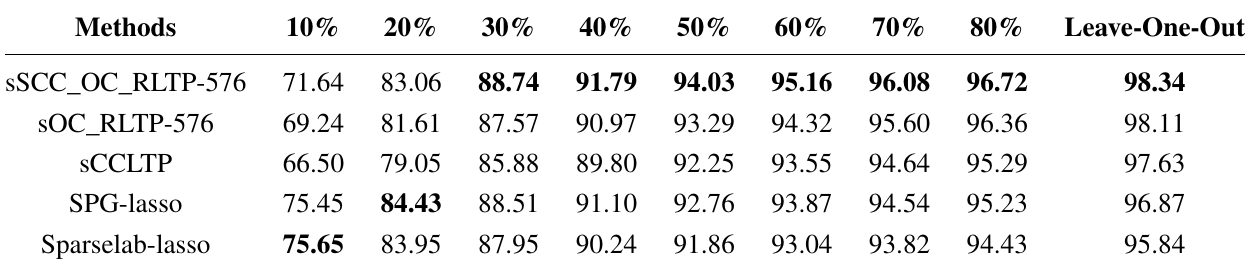
Table 9. Accuracy of infrared ATR (%) for the six methods under different training datasets. Methods